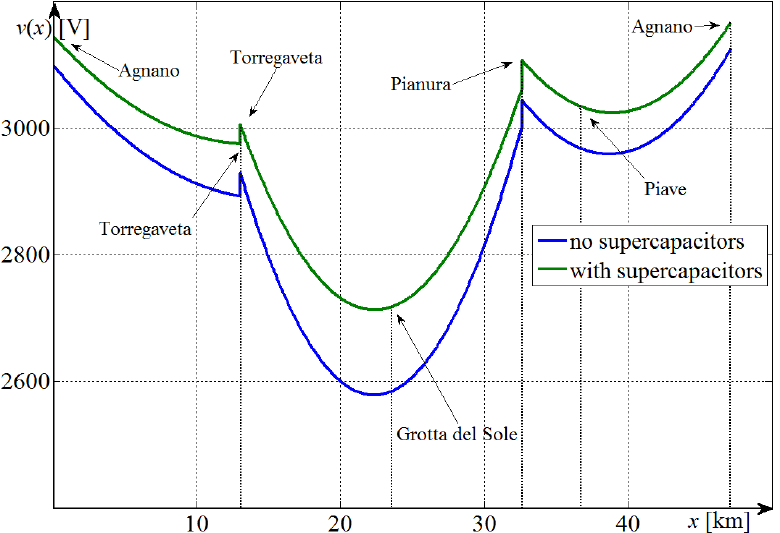
Figure 9. Comparison between voltage drops without and with EDLCs at 1.12 PM.